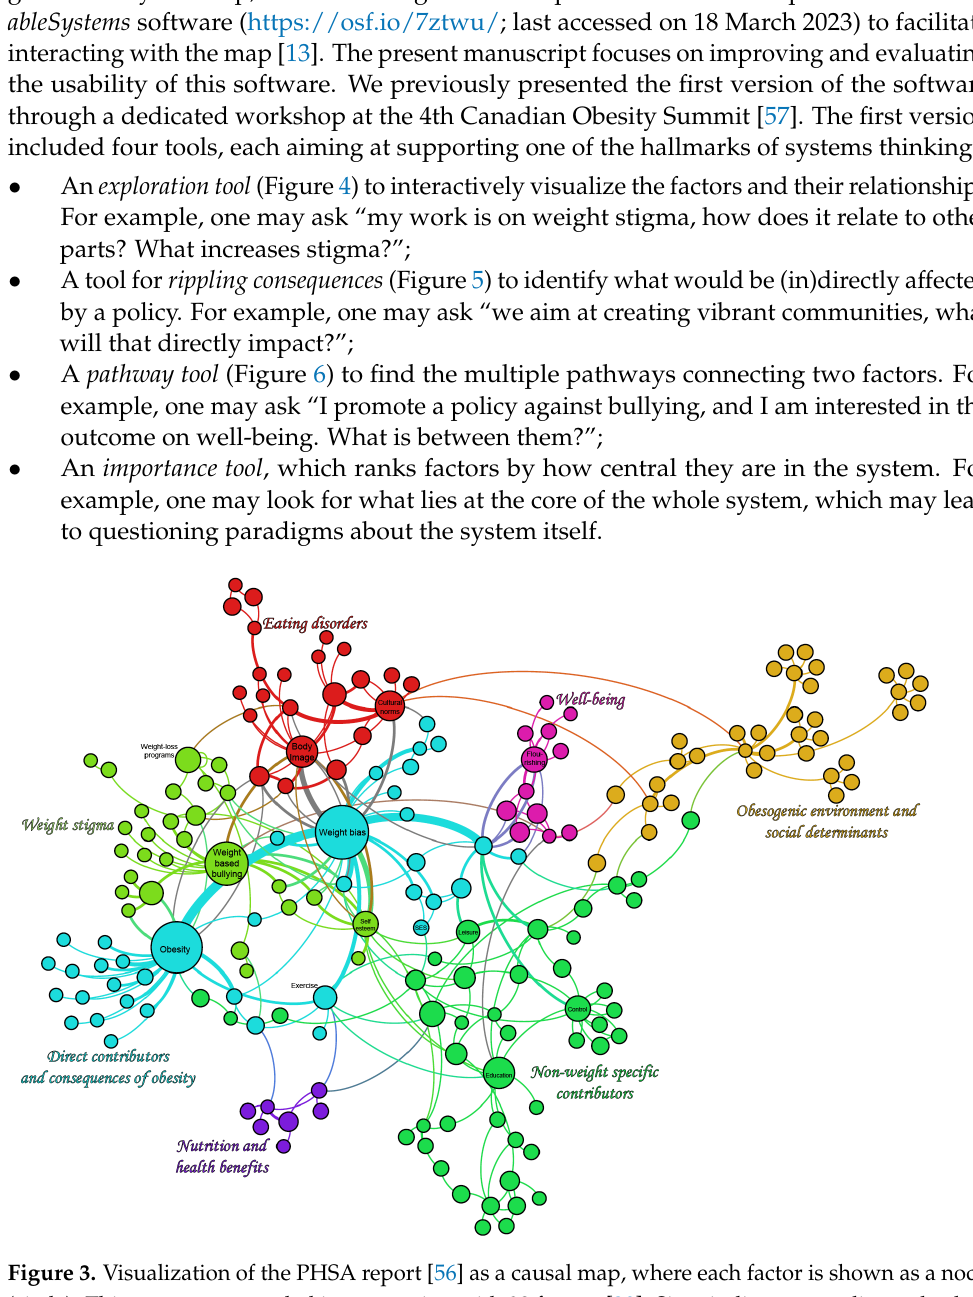
Figure 4. Exploring the causal map in the first Version of ActionableSystems . Policymakers can view relationships between high-level themes (triangles), or detail them to reveal individual factors (cir- cles). Green lines indicate a causal increase while red lines indicate a causal decrease.